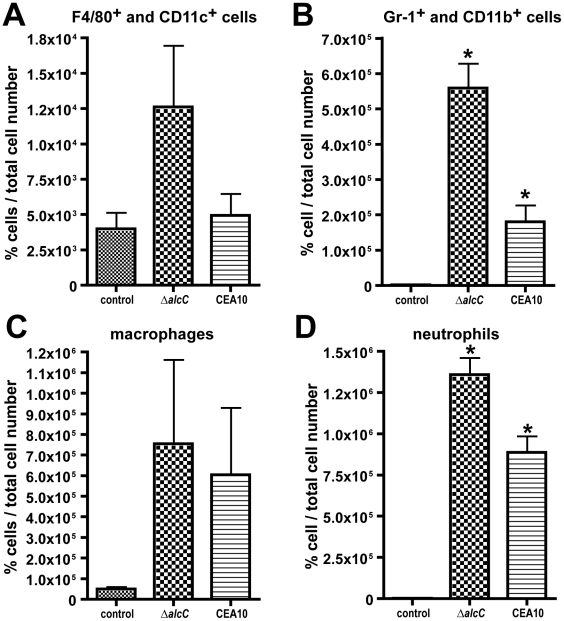
Characterization of cellular infiltrates in broncheoalveolar (BAL) fluids of triamcinolone immunosuppressed mice.Flow cytometry was used to identify (A) F4/80+/CD11c+ and (B) GR-1+/CD11b+ cells. Figures S3 and S4 show the corresponding Dot plots. Both cell types are elevated in ΔalcC inoculated mice. In agreement, differential cell counts demonstrate that macrophage and monocyte numbers were slightly increased in mice inoculated with ΔalcC (C) while neutrophil numbers were significantly elevated (D). *p<0.05. Results are presented as mean and standard error of N = 5 mice. The experiment was repeated in duplicate with similar results.